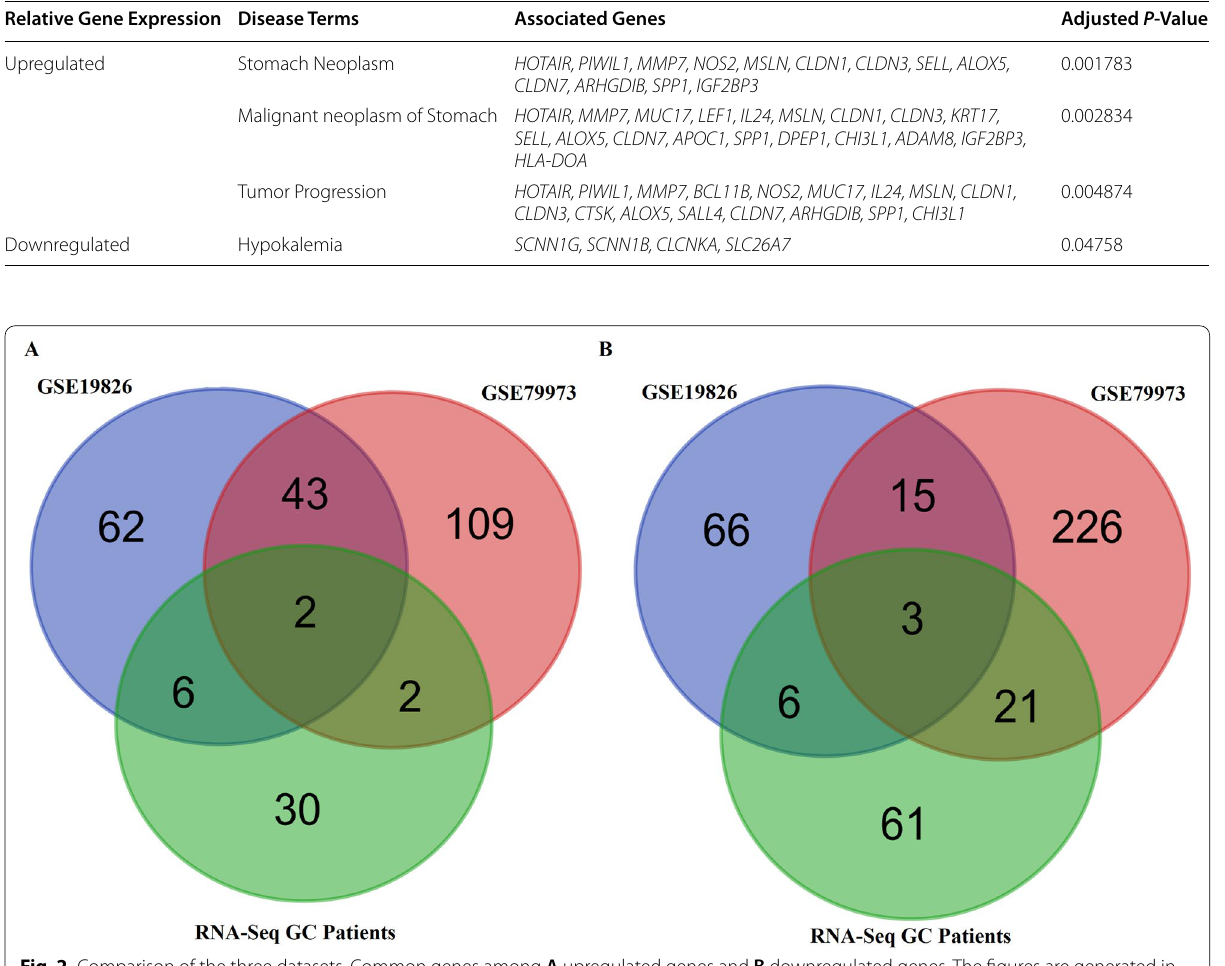
Table 4 Genes enriched in DisGeNET disease terms